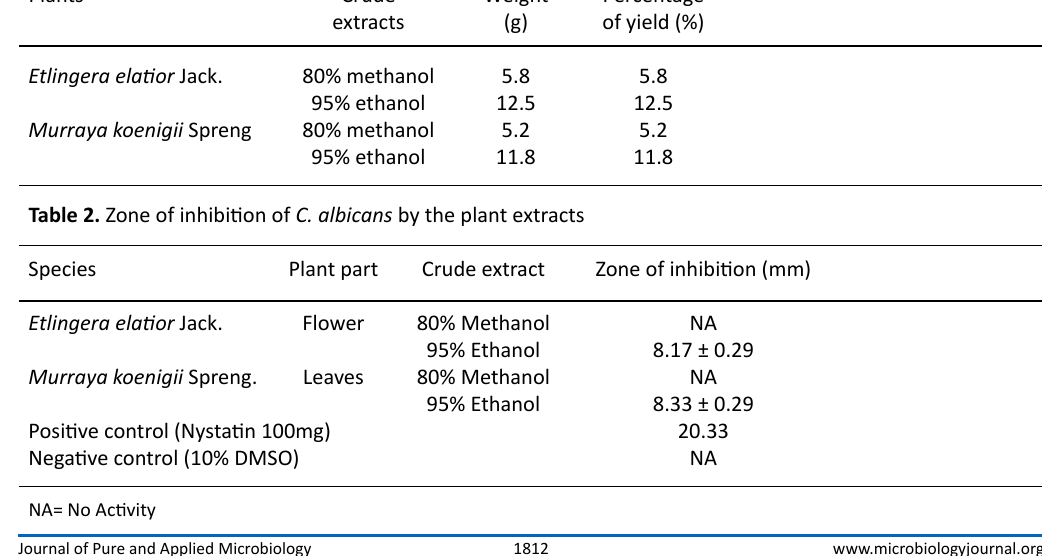
Table 1. The percentage of yield of the plant extracts with 80% methanol and 95% ethanol. Plants Crude Weight Percentage extracts (g) of yield (%) Etlingera elatior Jack.